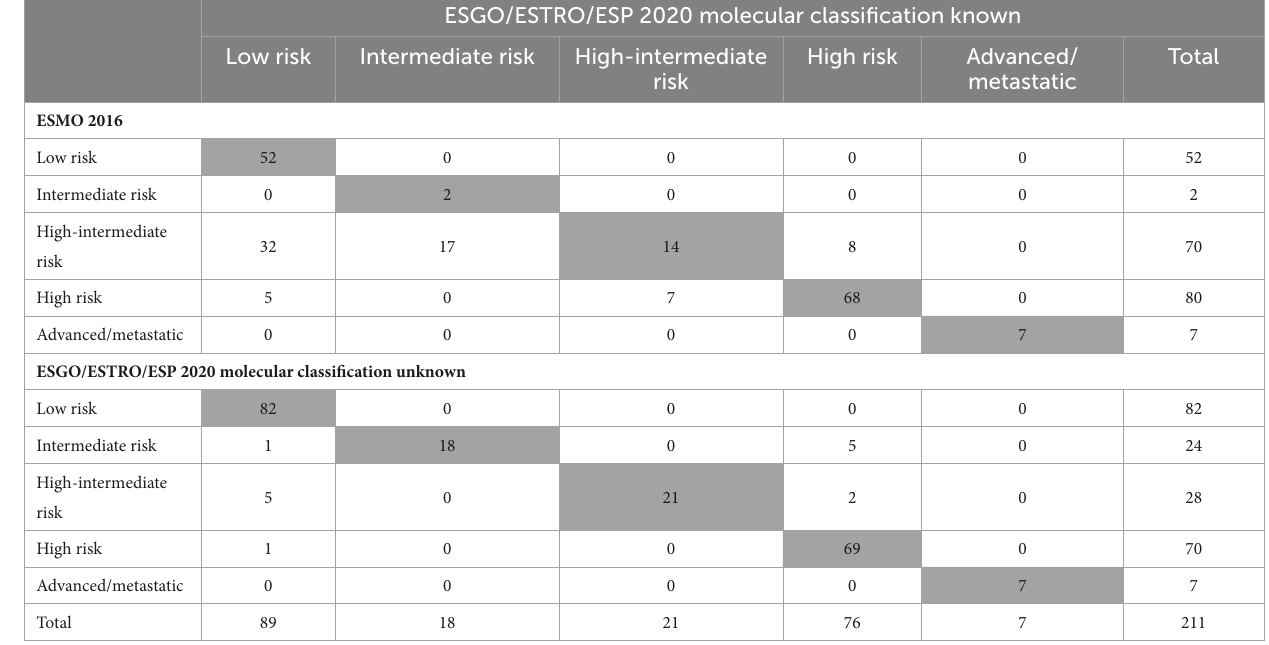
TABLE 3 Number of patients classified into risk groups according to ESGO/ESTRO/ESP 2020 guidelines and to 2016 recommendations. ESGO/ESTRO/ESP 2020 molecular classification